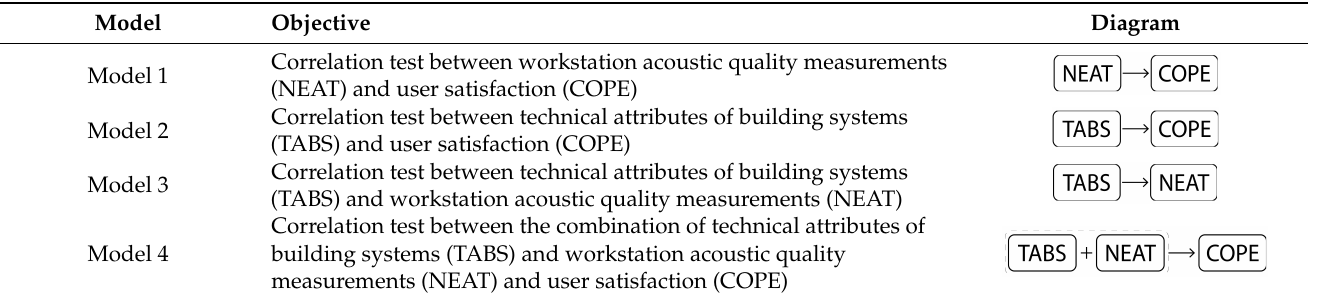
Table 6. Analysis models with objectives.